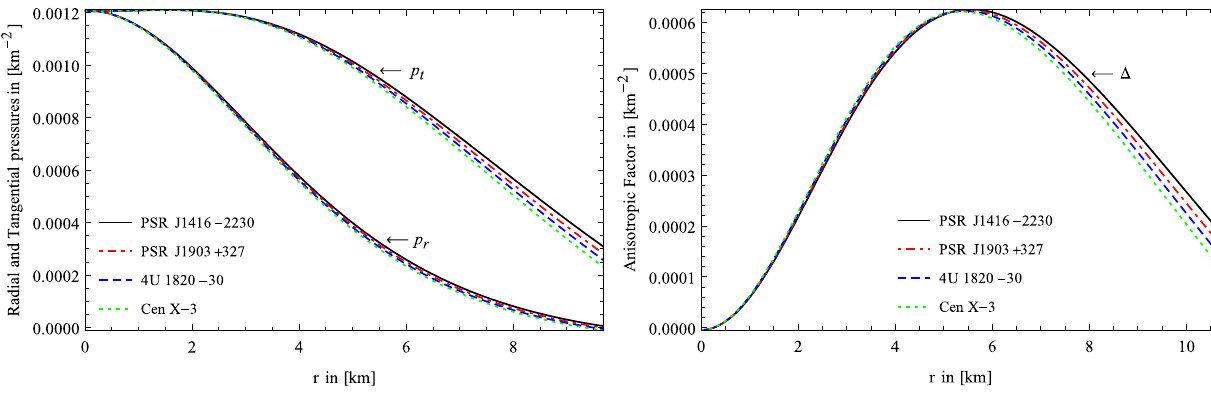
Fig. 2 The variation of radial and tangential pressures (left panel) and anisotropic factor (right panel) with the radial coordinate r for exper- imental statistics of four different compact stars. For plotting these